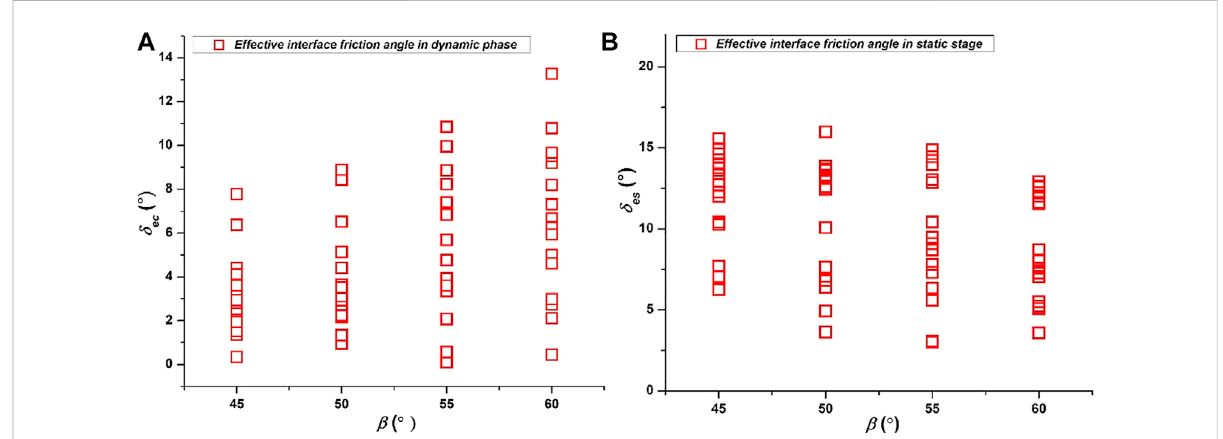
FIGURE 4 Variation of δ ec and δ es with interface inclination angle ( β ).